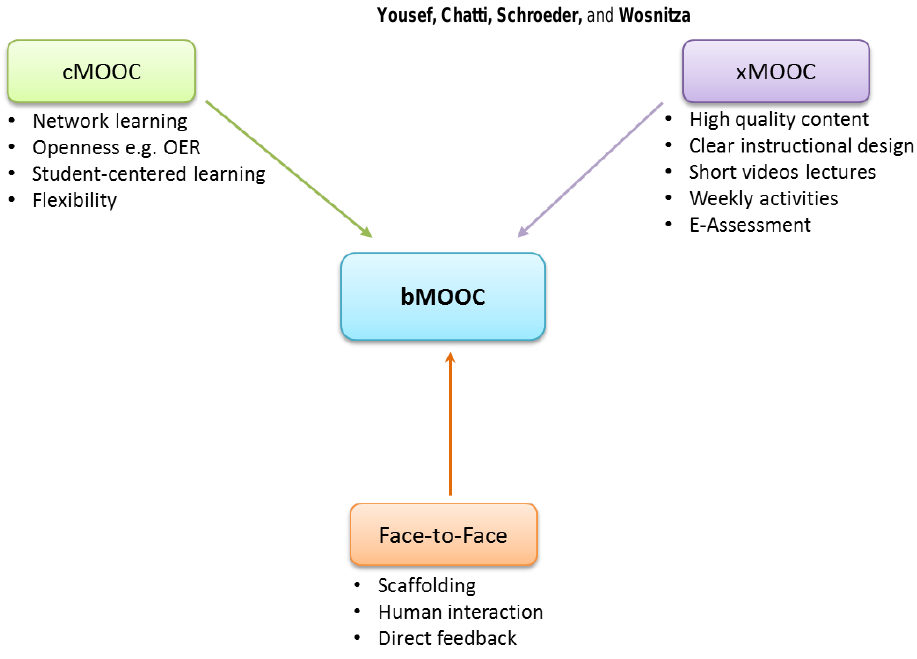
Figure 1 . bMOOC as the convergence of cMOOC, xMOOC, and face-to-face learning.